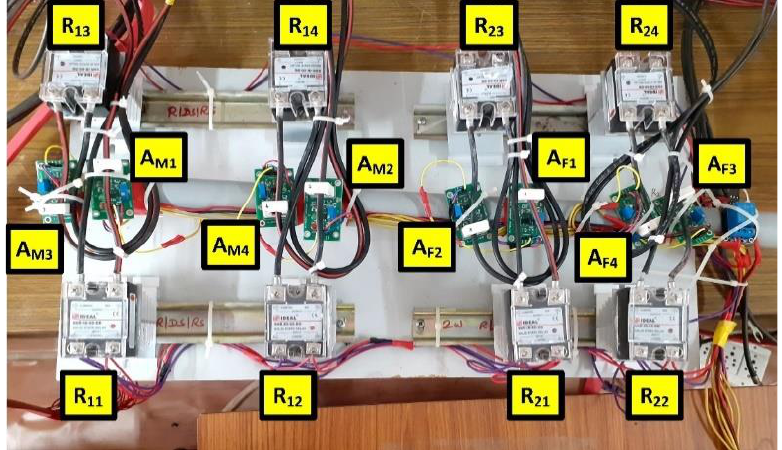
Figure 6. Photograph of current sensing unit.